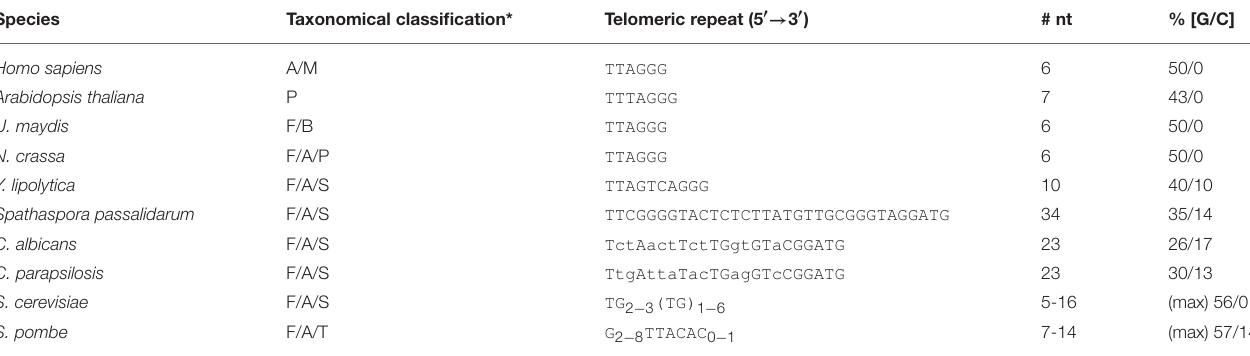
TABLE 1 | Variability of telomeric repeats.